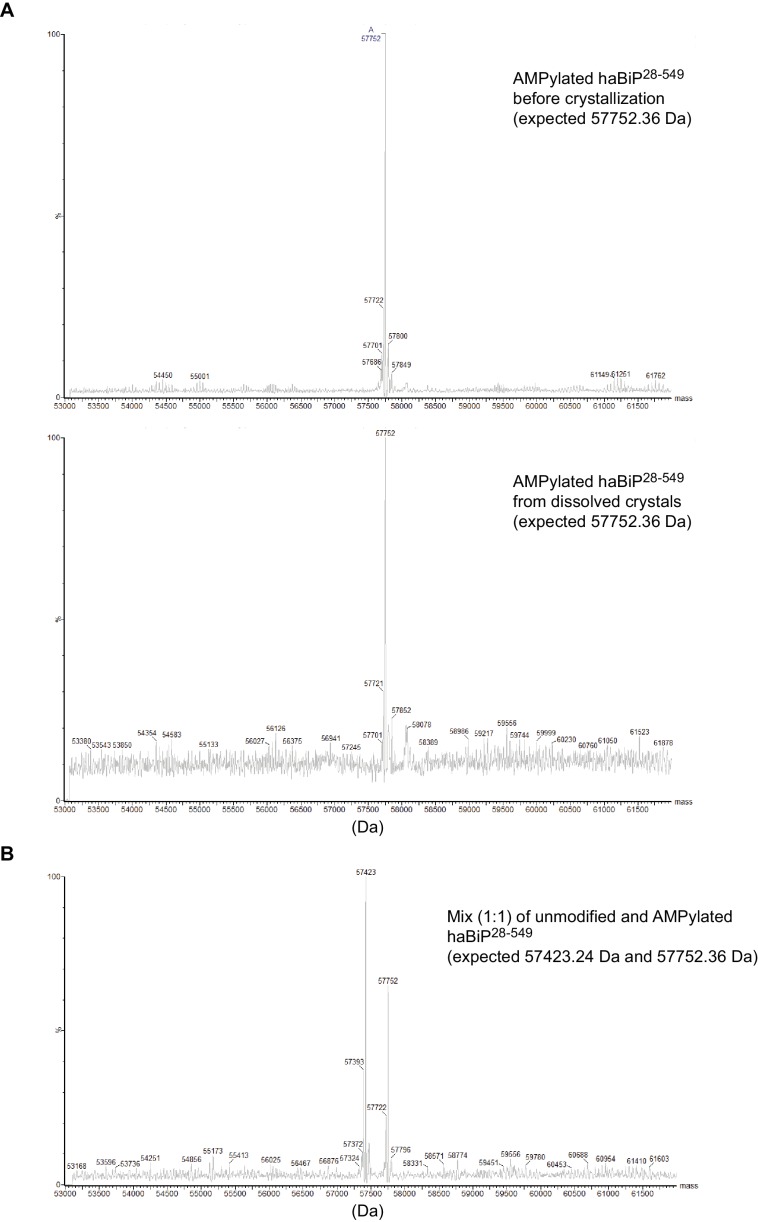
Mass spectrometry analysis of BiP used for crystallization.(A) Deconvoluted intact protein mass spectra of AMPylated haBiP28-549 protein before crystallization (input material) and from dissolved crystals (taken from the same trays as the one used to generate structure PDB 6EOE). The reconstructed mass values for the highest peaks are indicated on the spectra. Note that the mass of the most prominent peak in both spectra match the expected mass. (B) Analysis as in ‘A’ of a 1:1 mixture of unmodified and AMPylated haBiP28-549 proteins. Note the two prominent peaks corresponding to the expected masses of both species.